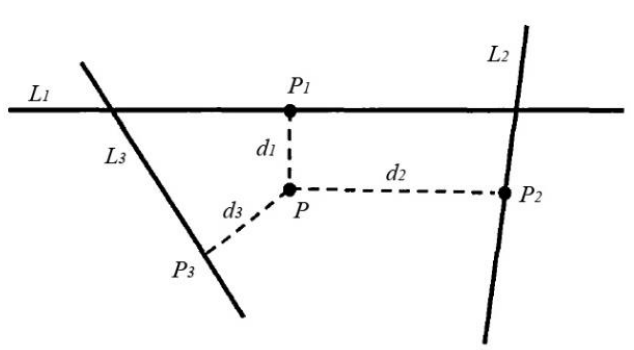
Figure 4. Demonstration of Correlation Matching Algorithm based on Projection (CMAP).